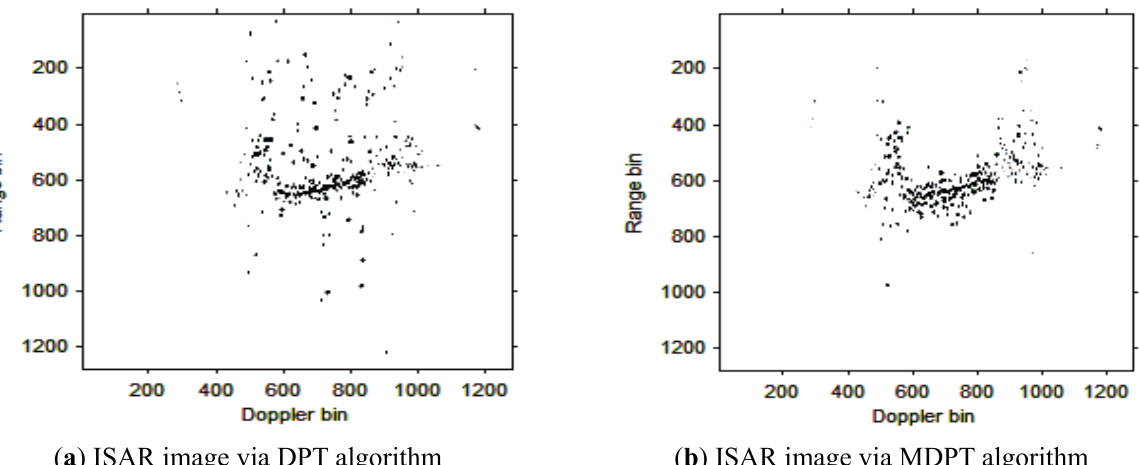
Figure 13. ISAR images at time t = 0.16 s based on DPT and MDPT algorithms.